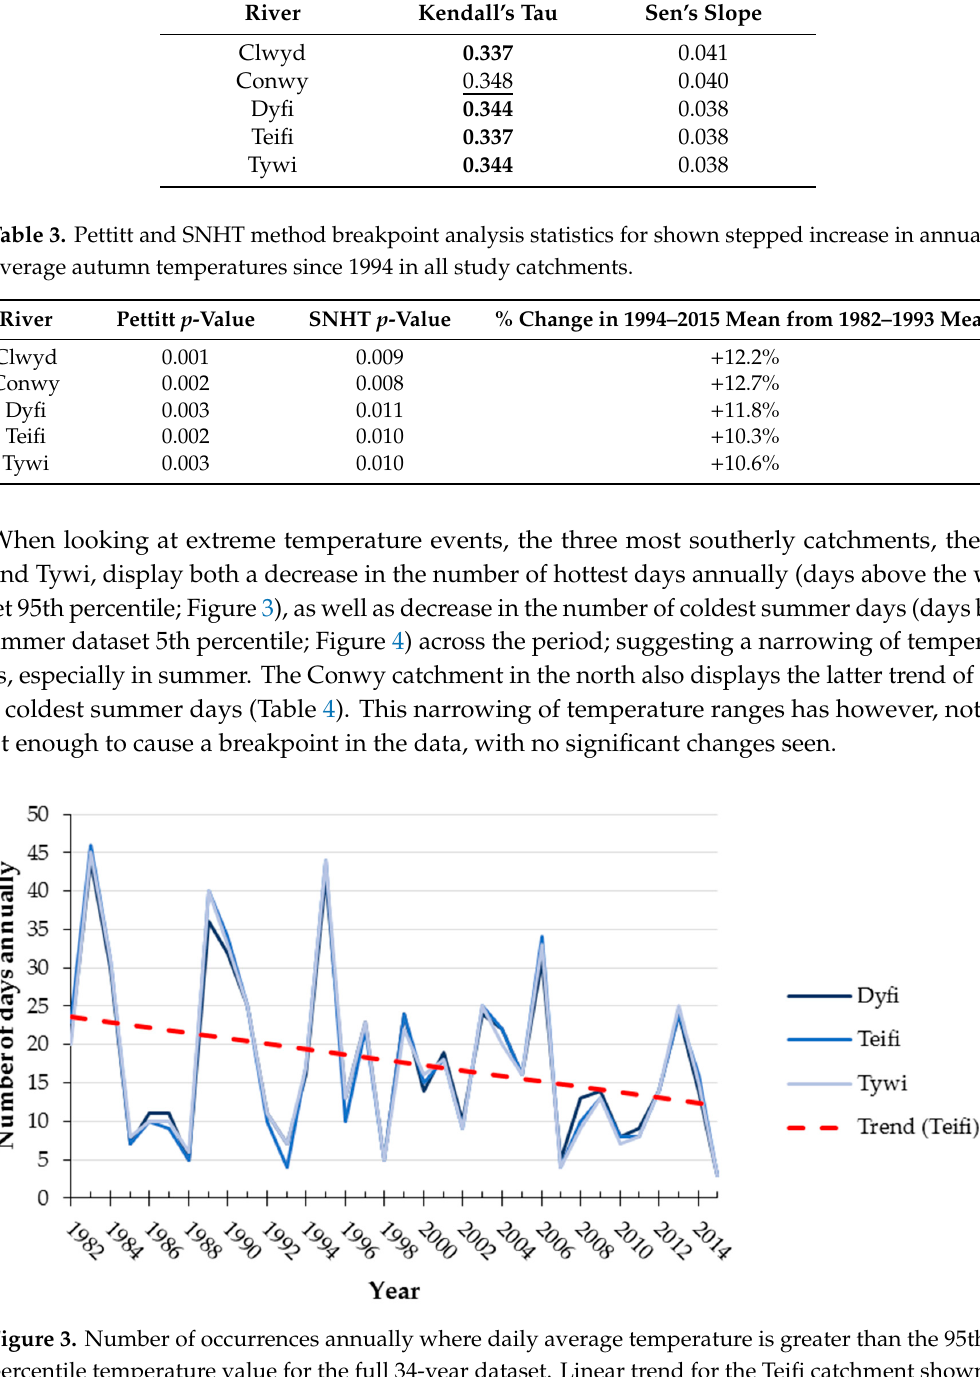
Table 2. Mann-Kendall trend analysis and Sen’s slope indicator results for average autumn air temperatures trends (1981–2015) in each of the five study catchments. Values for Kendall’s Tau underlined are significant at p < 0.05, and those in bold are significant at p < 0.01. River